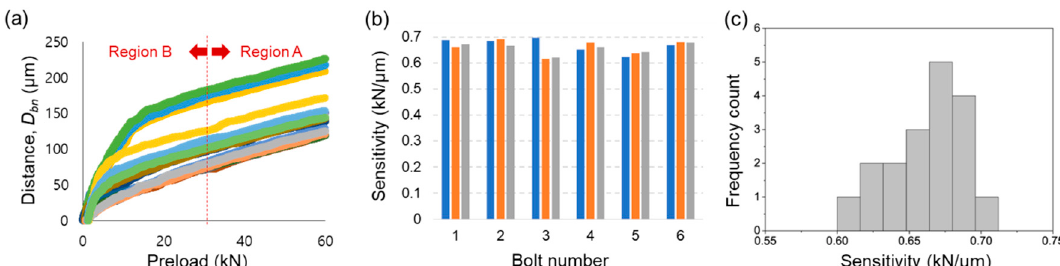
Figure 6. Experimental results: ( a ) variation of distance as a function of preload, ( b ) comparison of the sensitivity of L-PMS from the region A for each bolt (the same color corresponds to the same set of test), and ( c ) histogram for the sensitivities from all the bolts.